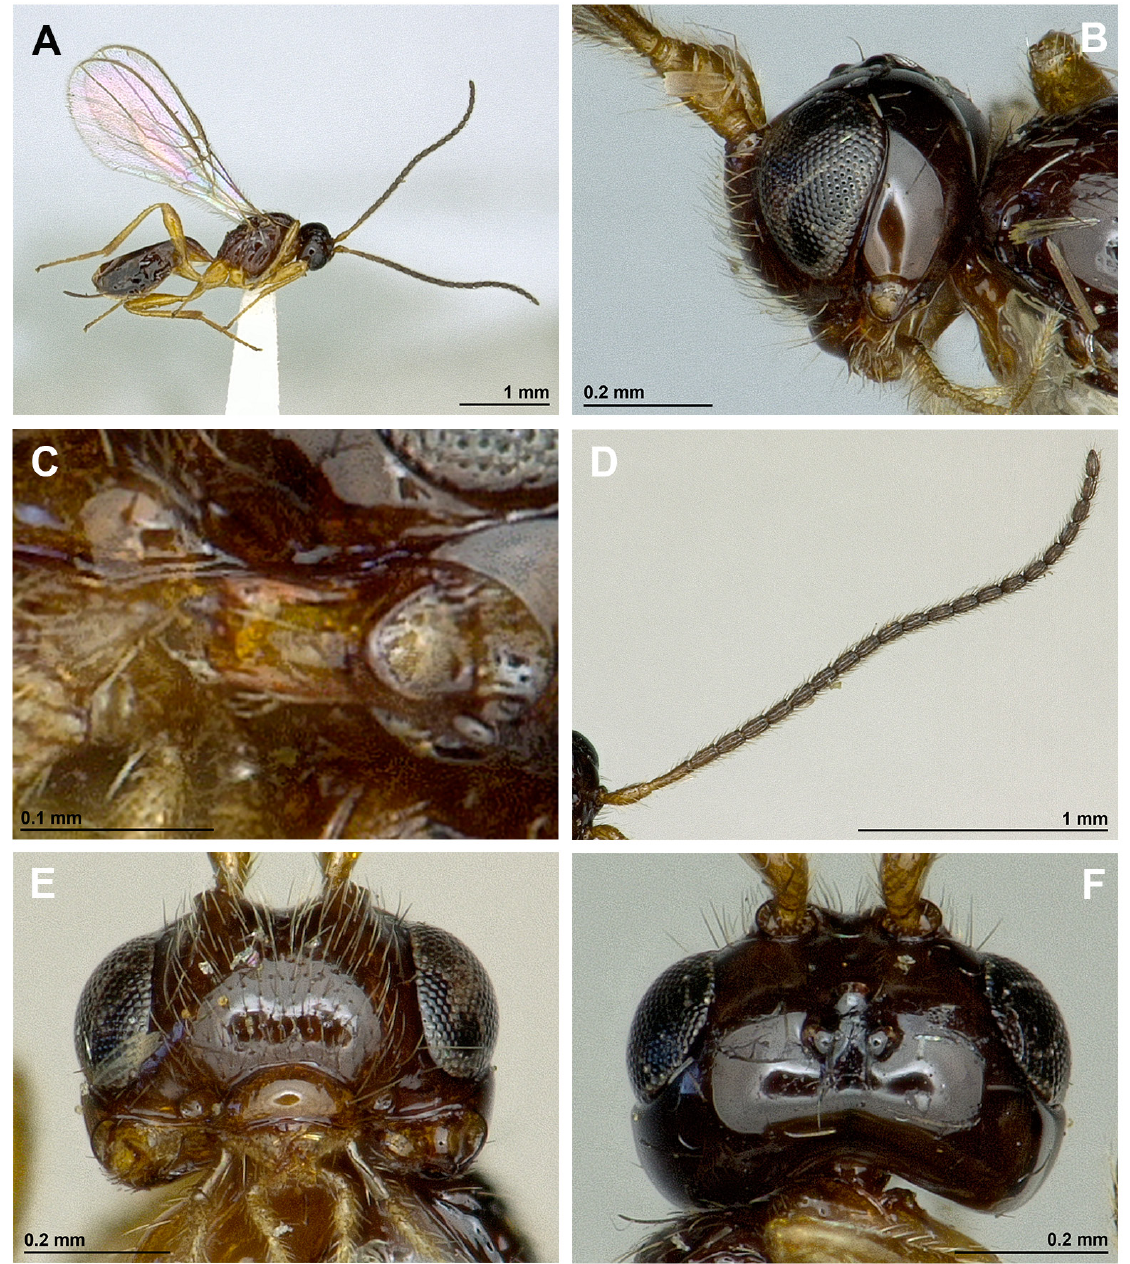
Fig. 4. Synaldis fritzi Peris-Felipo, sp. nov., ♀. A . Habitus, lateral view. B . Head, lateral view. C . Mandible. D . Antenna. E . Face, front view. F . Head, dorsal